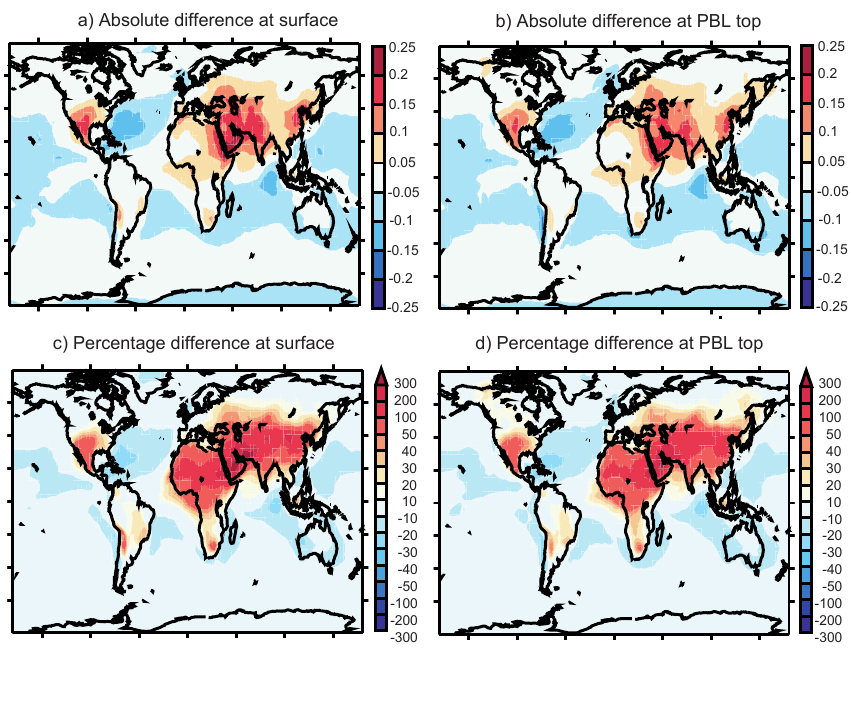
Fig. 8. Annual mean absolute difference in κ arising from present day emissions compared to a pre-industrial scenario ( κ present − κ preindustrial ) at (a) surface and (b) PBL height. Panels (c) and (d) show the percentage change due to present day